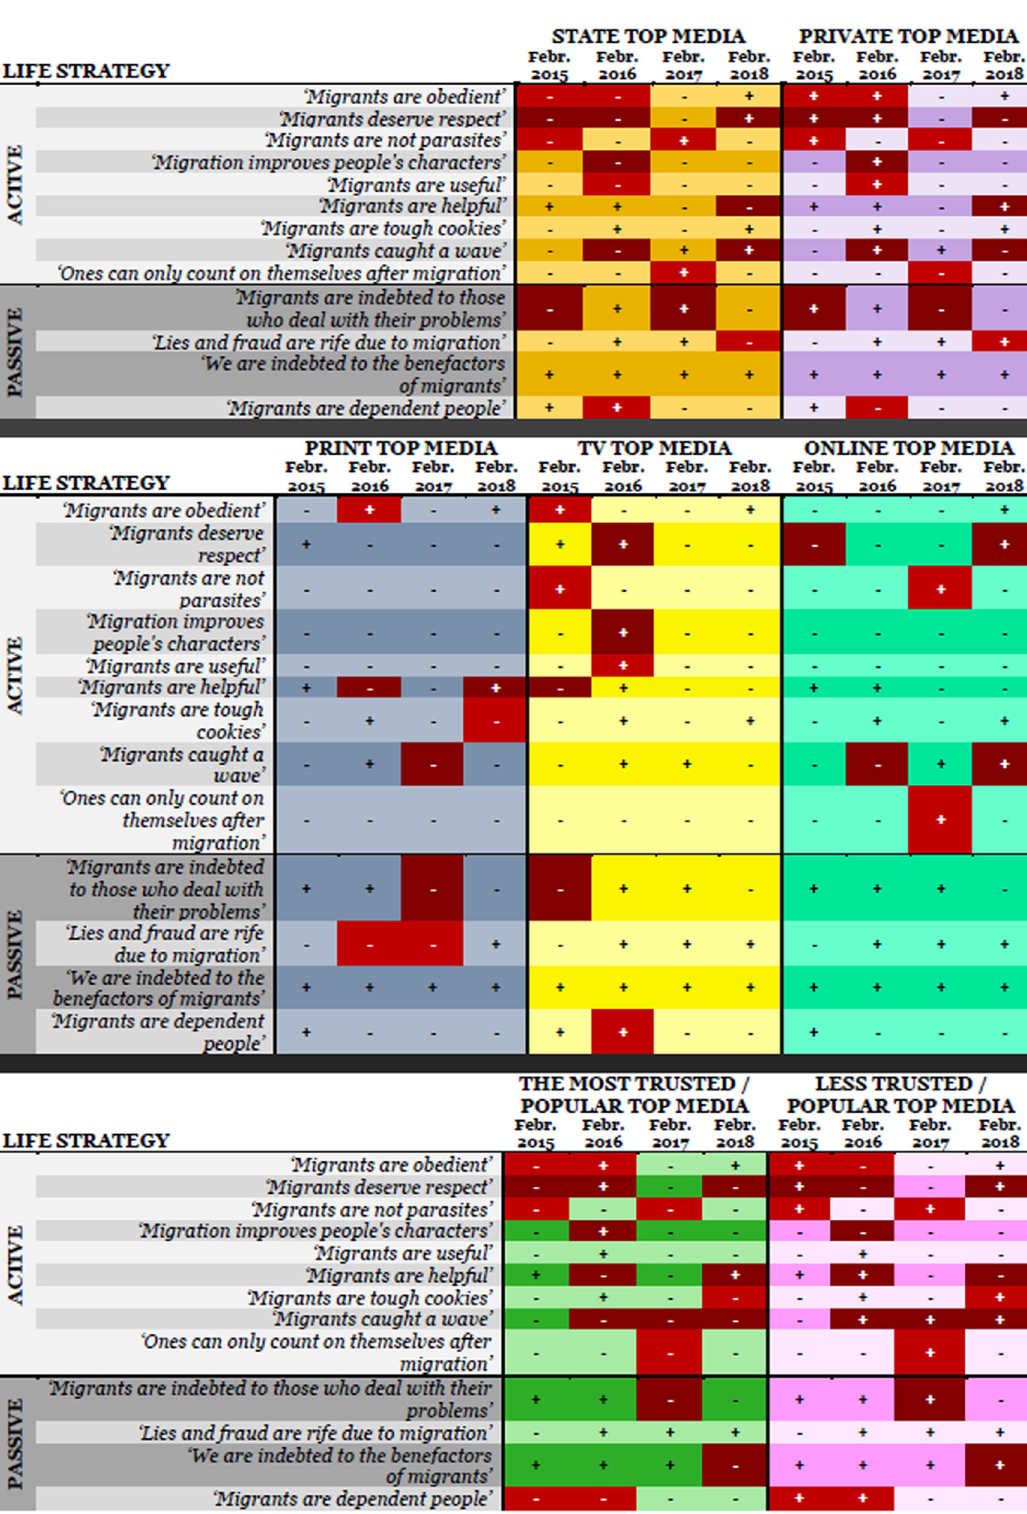
HUMANITIES AND SOCIAL SCIENCES COMMUNICATIONS| (2021) 8:289